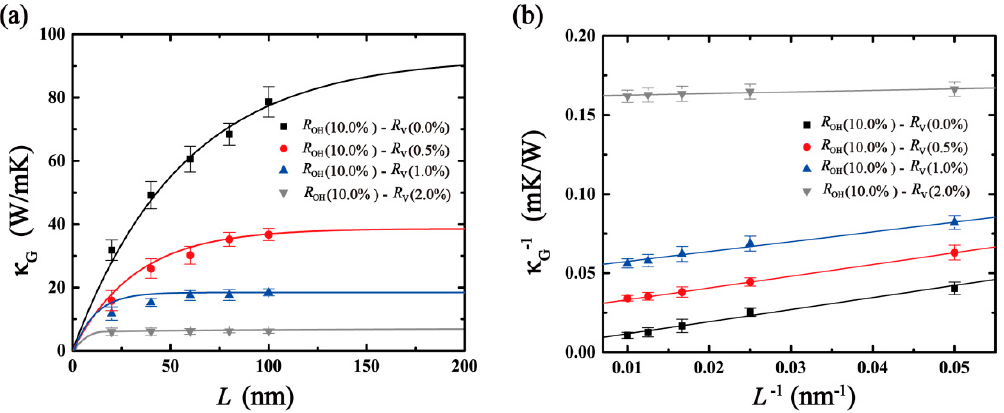
Figure 8. Length dependence of defect-GO’s thermal conductivity. Solid lines are best fit to Equation (4). ( a ) The relationship between κ and L , ( b ) the relationship between κ − 1 and L − 1 .